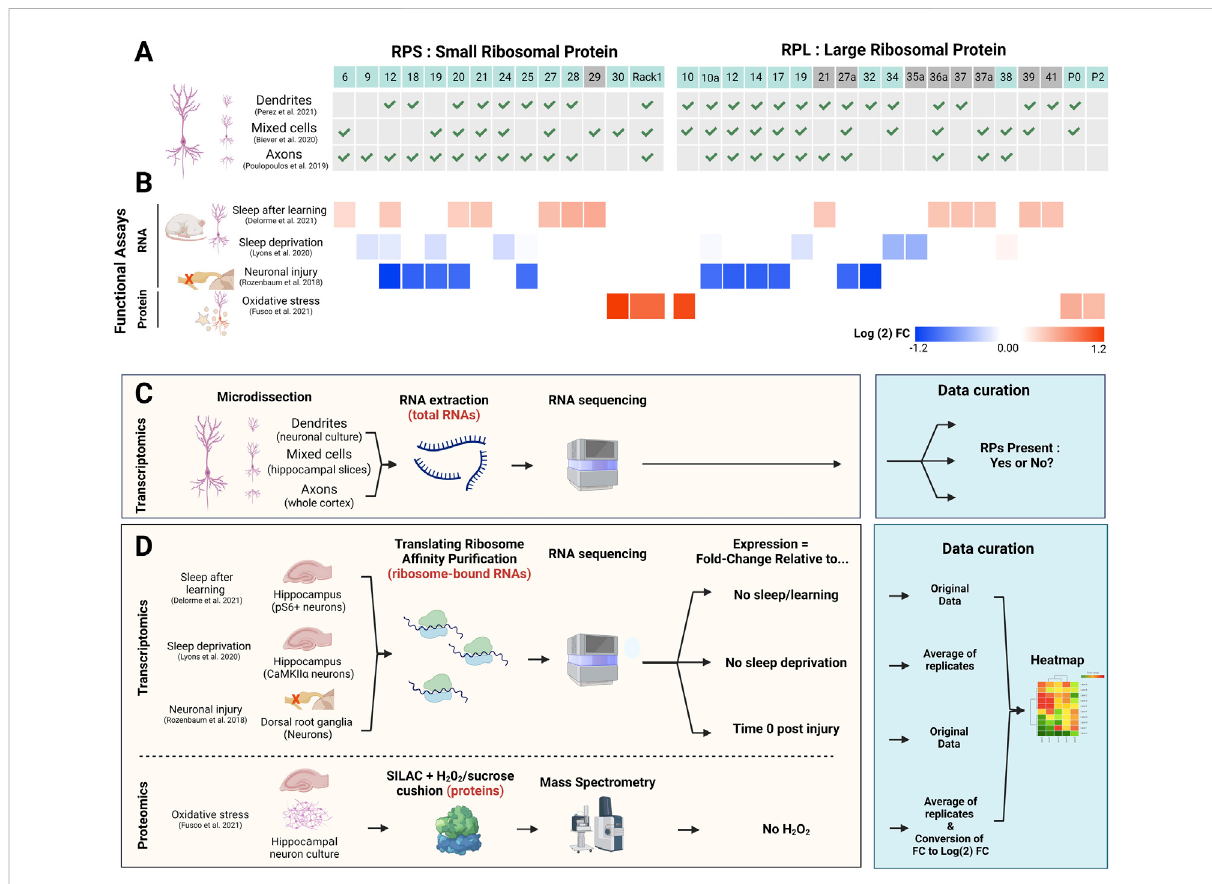
FIGURE 2 Contribution of RPs to ribosome heterogeneity in neurons and functional signi fi cance. (A) Table indicating the presence (green check mark) or absence of select RP (top line) mRNAs in whole neurons vs. dendrites or axons, according to previous studies (Poulopoulos et al., 2019; Biever et al., 2020;Perez etal., 2021a).RPlocation(non-surface: greyboxes; surface:blueboxes) wasdetermined usinghumanribosomestructure(PDB: 4V6X). (B) Heatmap (Morpheus, https://software.broadinstitute.org/morpheus) representing heterogeneous expression of selected RPs in neurons from in vivo studies in rodents or in vitro studies. The colour bar depicts log (2) fold changes (FC) of the particular conditions (indicated on the left) against control condition values (see D and (Rozenbaum et al., 2018; Lyons et al., 2020; Delorme et al., 2021; Fusco et al., 2021) for experimental details). From top to bottom: 1) 13 RP transcripts on membrane-bound ribosomes in activated (pS6+) neurons in the hippocampus following contextual fear conditioning and subsequent sleep in mice (Delorme et al., 2021). 2) 7 RP mRNAs affected by acute (5 h) sleep deprivation in excitatory neurons (CamKII α +) in the mouse hippocampus (Lyons et al., 2020). 3) The fi ve largest changes for small and large ribosomal subunits (10 RPs) in dorsal root ganglion (DRG) neurons following sciatic nerve injury, 4 h after injury (Rozenbaum et al., 2018). 4) 5 RPs that are signi fi